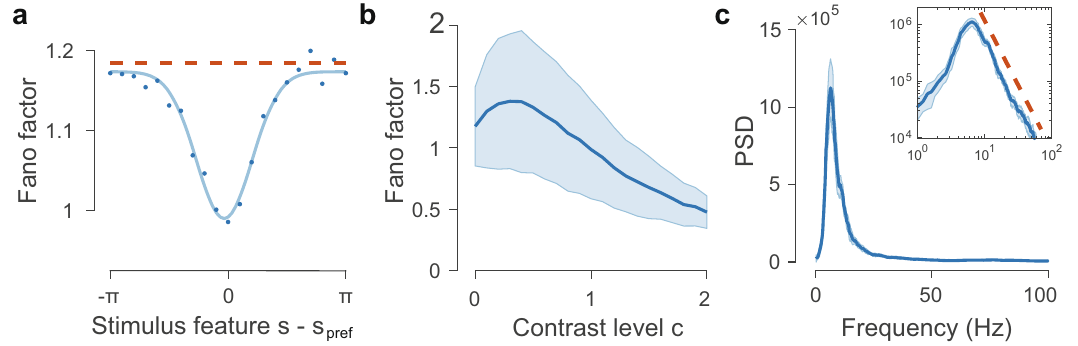
Fig. 3 | FNS accounts for neural response properties. a Fano factor tuning of neural responses for varying stimulus feature values s relative to the neuron's preferred stimulus s pref for contrast level c =1 (dots). Dashed line corresponds to spontaneous activity when c =0. Fano factor is calculated using spike counts over100mstimewindows. b TroughoftheFanofactorin( a )asafunctionofthe contrastlevel c ofthefeedforwardinput.Shadesindicatethestandarddeviation